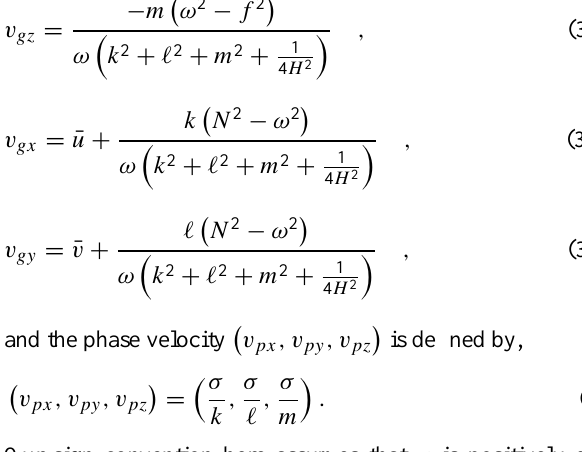
Fig.1 ‘ Open circle ’: 72 hours averaged velocity of winter zonal wind; ‘ Cross ’: 72 Fig. 1. Open circle: 72h averaged velocity of winter zonal wind; hours averaged velocity of winter meridional wind; ‘ Dot ’: 96 hours averaged Cross: 72h averaged velocity of winter meridional wind; Dot: 96h velocity of summer zonal wind; ‘ Line ’: 96 hours averaged velocity of summer averaged velocity of summer zonal wind; Line: 96h averaged ve- meridional wind. The vertical straight line is the reference line for zero velocity. locity of summer meridional wind. The vertical straight line is the reference line for zero